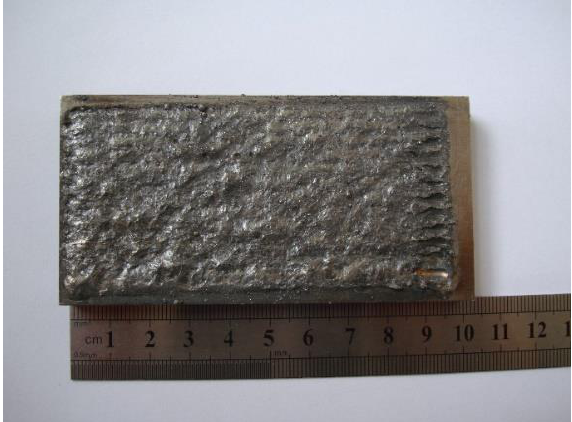
Figure 3. Macroscopic morphology of the sample after laser-cladding.